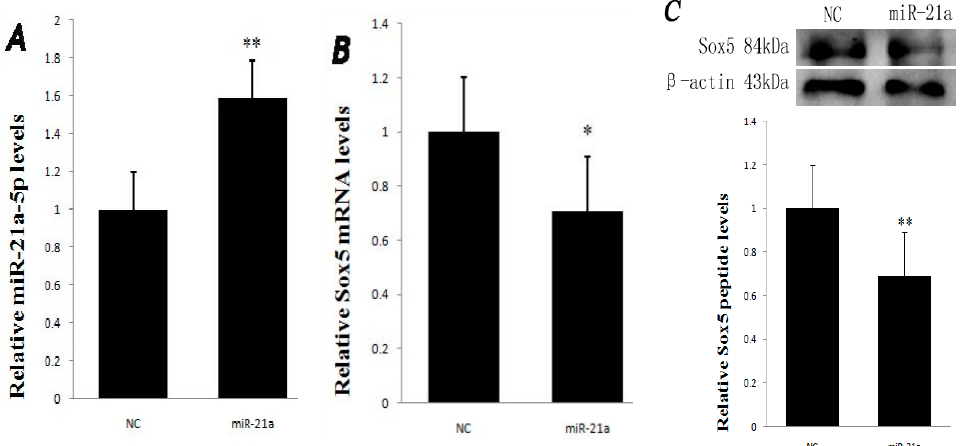
Figure 2. Expression levels of miR-21a-5p and Sox5 mRNA in NC and miR-21a-5p transfected groups: ( A ) the miR-21a-5p expression level was significantly higher in the miR-21a group than in the NC group (miR-21a: 1.59, NC: 1); ( B ) many significant differences were found in the Sox5 mRNA expression between the NC and miR-21a groups (miR-21a: 0.71, NC: 1); and ( C ) the Sox5 protein amount in melanocytes transfected with miR-21a as well as the negative control. Data are mean ± SD. * p < 0.05, ** p < 0.01.